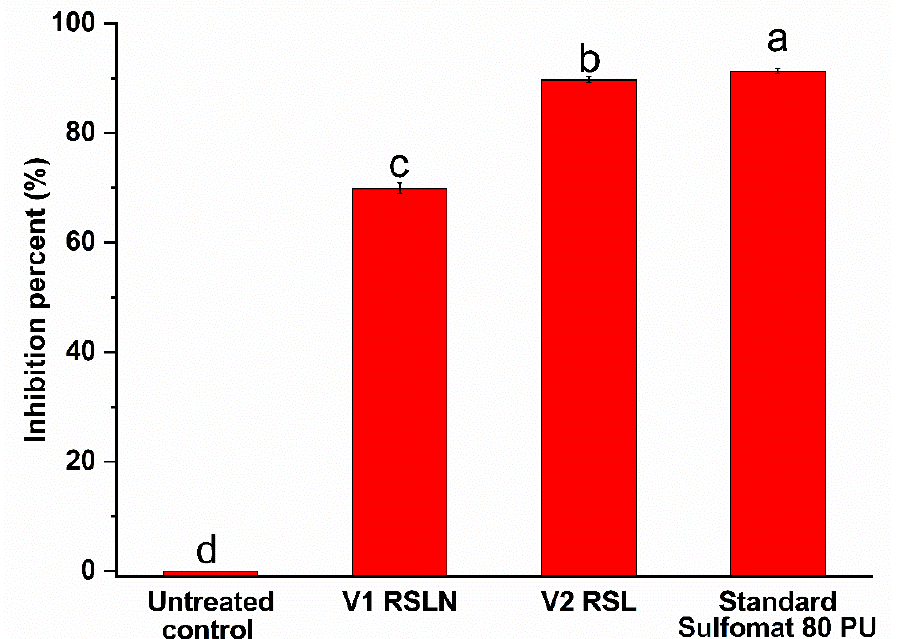
Figure 7. Graphical representation of the effect of tested materials in control of powdery mildew— Podosphaera leucotricha . Values without a common letter differ ( p < 0.05) as analyzed by one-way ANOVA and the Tukey test.